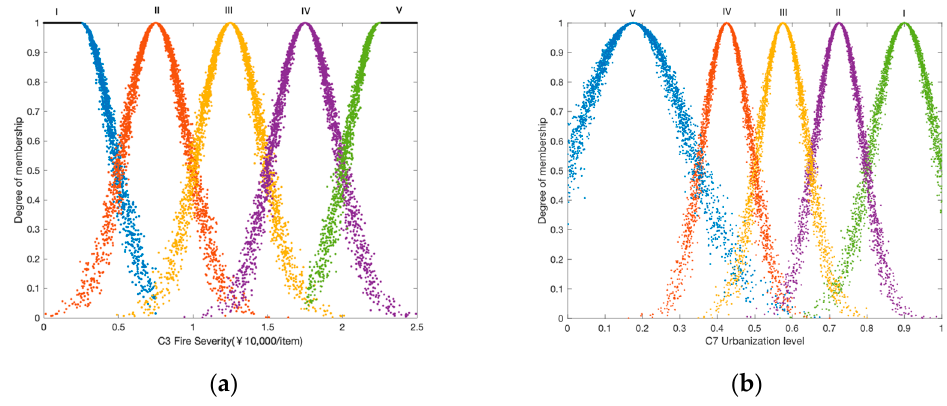
11 of 15 Table 4. Grading table of evaluation indexes. Indicator